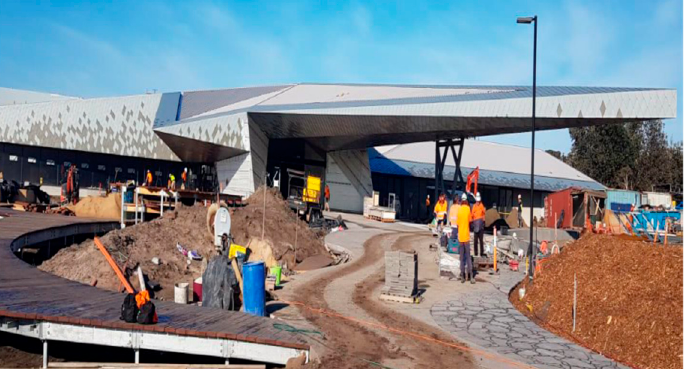
Figure 3. Cantilevered Roof and Box Gutters of Builder C3 (Adapted from Phillip Island Nature Parks [41]).